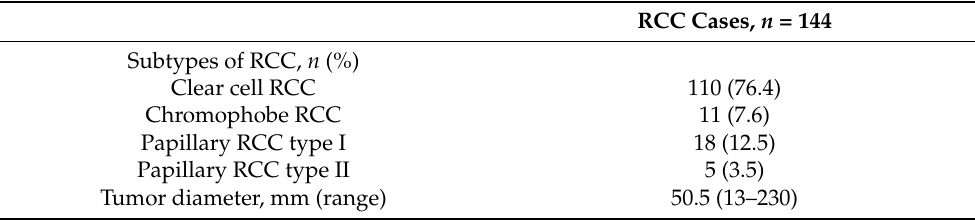
Table 1. Clinical and pathological characteristics of patients with renal cell carcinoma (RCC).